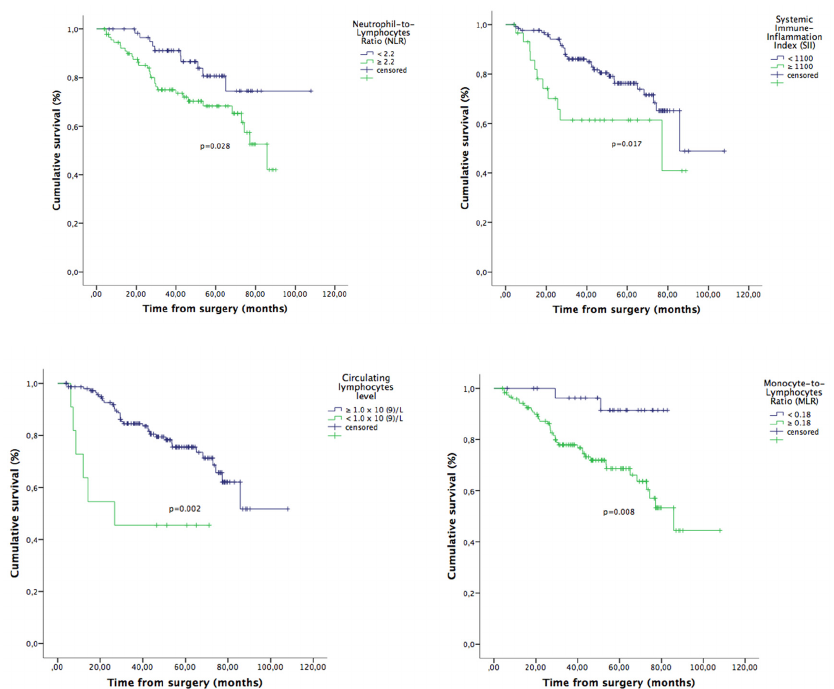
Figure 1. Overall survival in all patients included ( n = 155): Impact of pre-treatment Neutrophil-to-Lymphocyte (NLR; cut-o ff ≥ 2.2), Systemic Immune-Inflammatory Index (SII; ≥ 1100), Monocyte-to-Lymphocyte Ratio (MLR; ≥ 0.18), and circulating lymphocytes ( < 1.0 × 10 9 / L) on overall survival (OS) of the endometrial cancer (EC) patients.